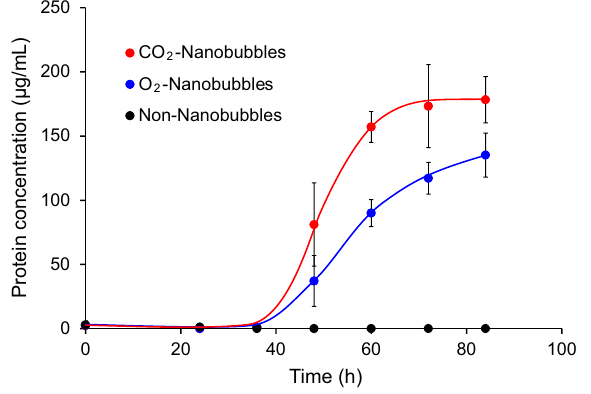
Figure 4. Concentration of protein generated by the cultivation of P . aeruginosa in the Cooper’s medium. Protein concentration in the carbon dioxide nanobubbles medium (red closed circle), oxygen nanobubbles medium (blue closed circle) and nanobubbles-free medium (black closed